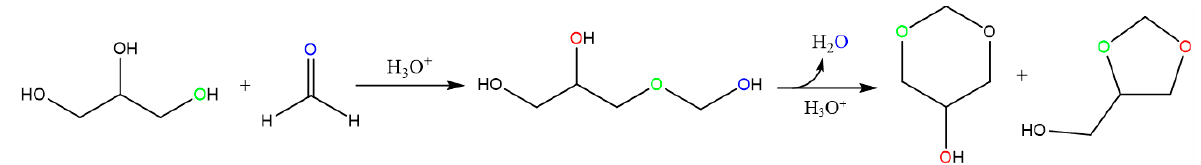
Figure 1. Formation of FA-glycerol hemiacetal (Gly-HA) and cyclic acetals (Gly-A). The colors are used to visualize the inclusion sites of various oxygen atoms in the reaction products.